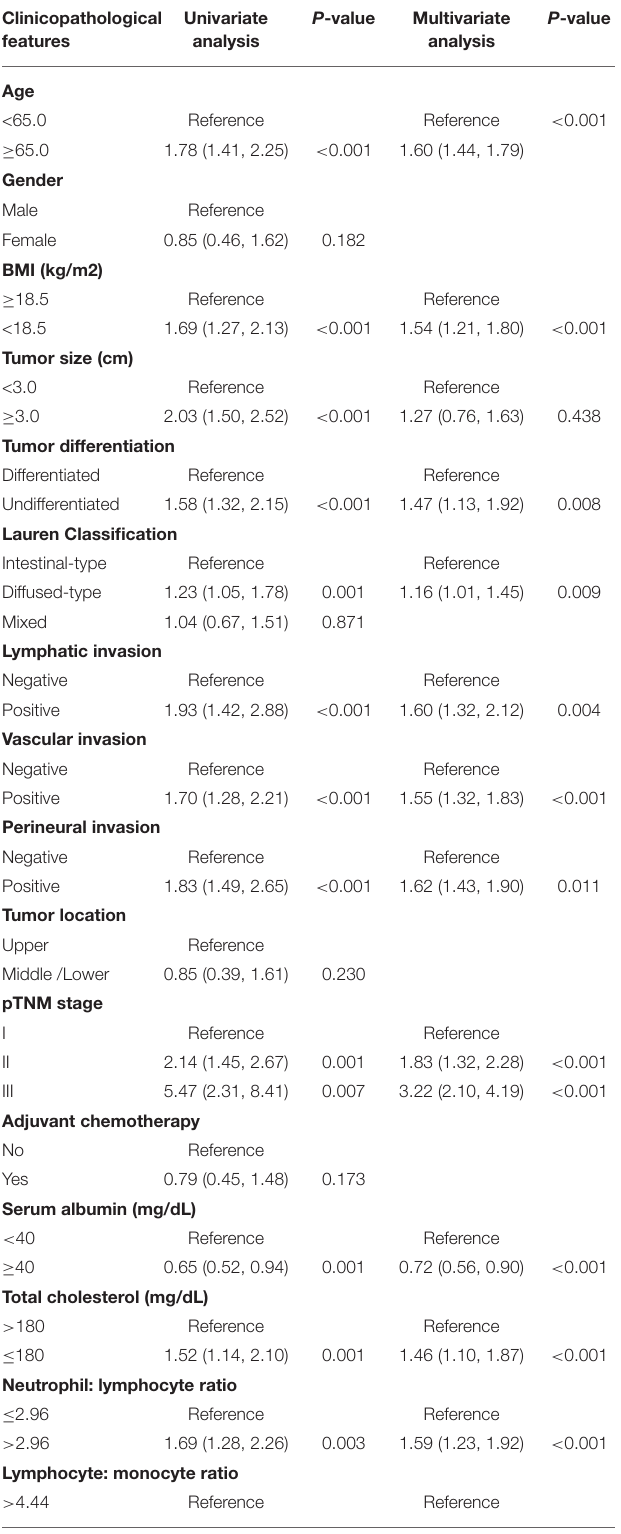
TABLE 2 | Univariate and multivariate analysis of clinicopathologic variables in relation to OS in patients with GC. Clinicopathological features